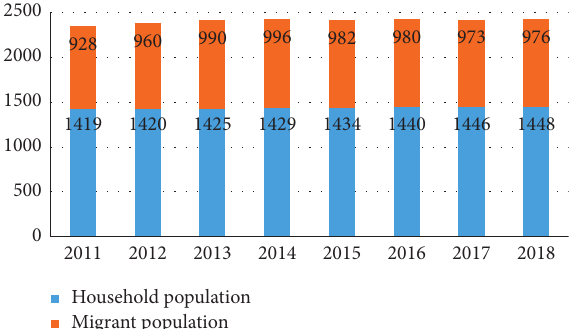
Figure 4: Population structure of Shanghai’s permanent residents, 2011–2018 (unit: